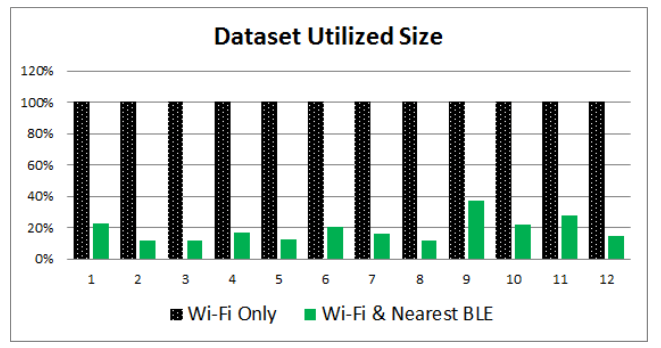
Figure 7. Fingerprint dataset size utilization: Wi-Fi only vs. nearest BLE and